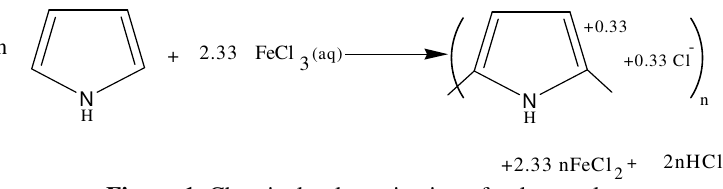
Figure 1. Chemical polymerization of